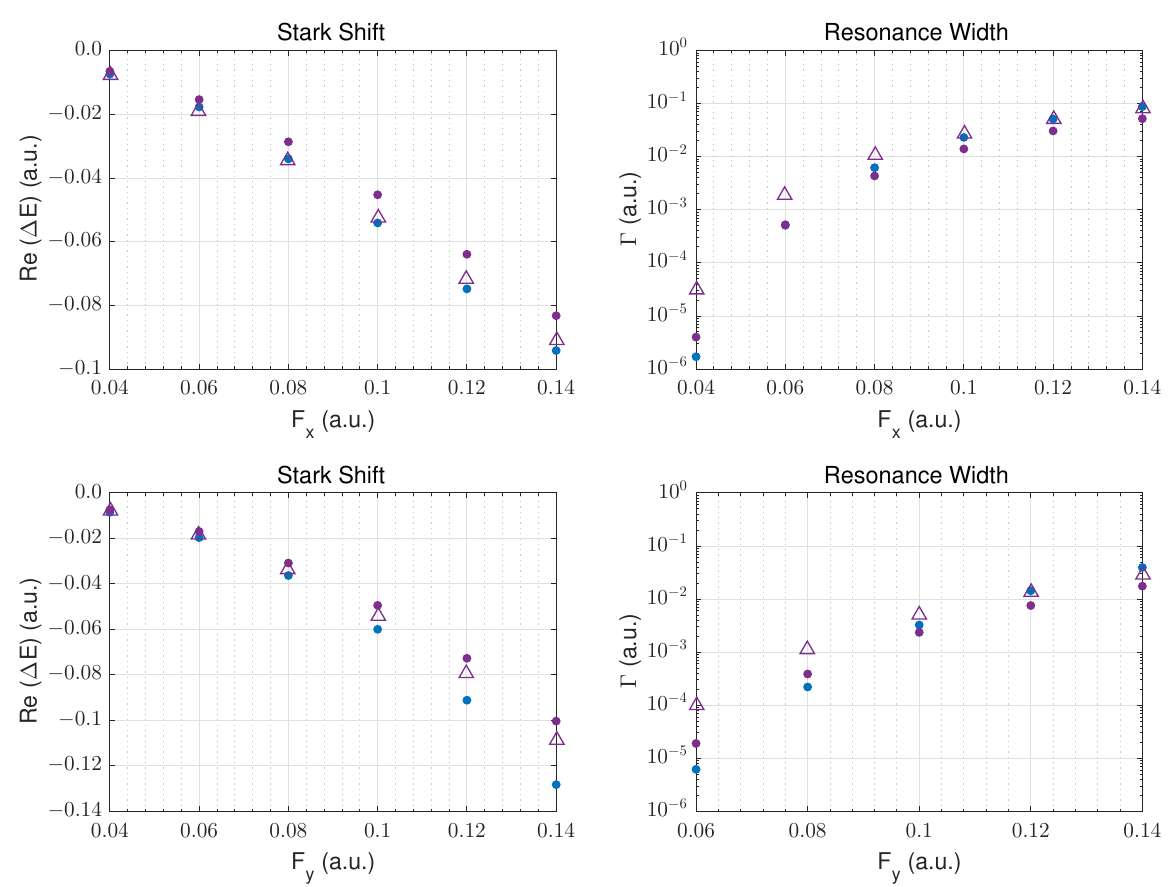
Figure 8. The left panel displays dc Stark shifts, while the right panel displays full-widths for the water molecule. The blue dots ( • ) are the present DS (2) results calculated at the level of (cid:96) max = 3, the purple dots ( • ) are the HF results, and the purple triangles ( (cid:52) ) are the CCSD(T)